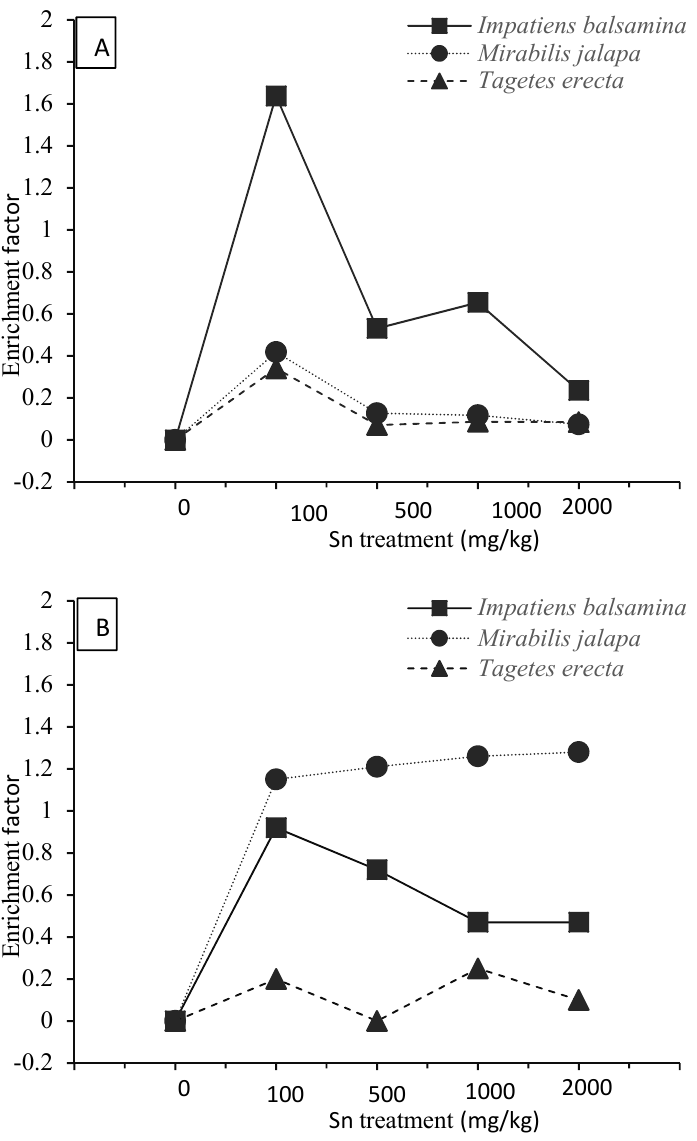
Figure 2. Sn accumulation potential of three ornamental plants: ( A ) bioconcentration factor (BCF) (concentration ratio of root to soil) of three ornamental plants; ( B ) translocation factor (TF) (concentration ratio of shoot to root) of three ornamental plants.